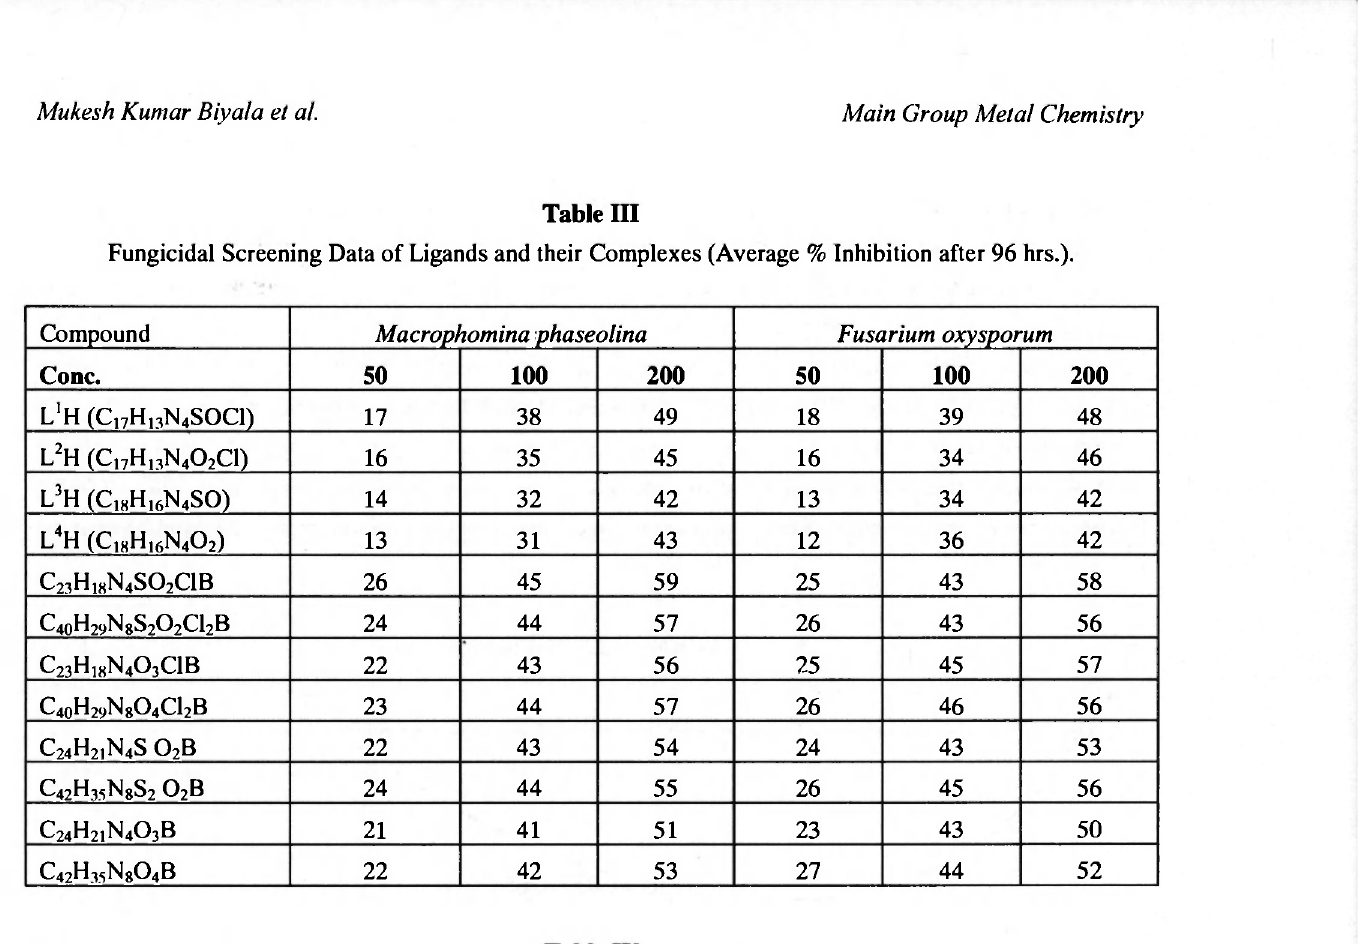
Fungicidal Screening Data of Ligands and their Complexes (Average % Inhibition after 96 hrs.). Compound Macrophomina phaseolina Cone.